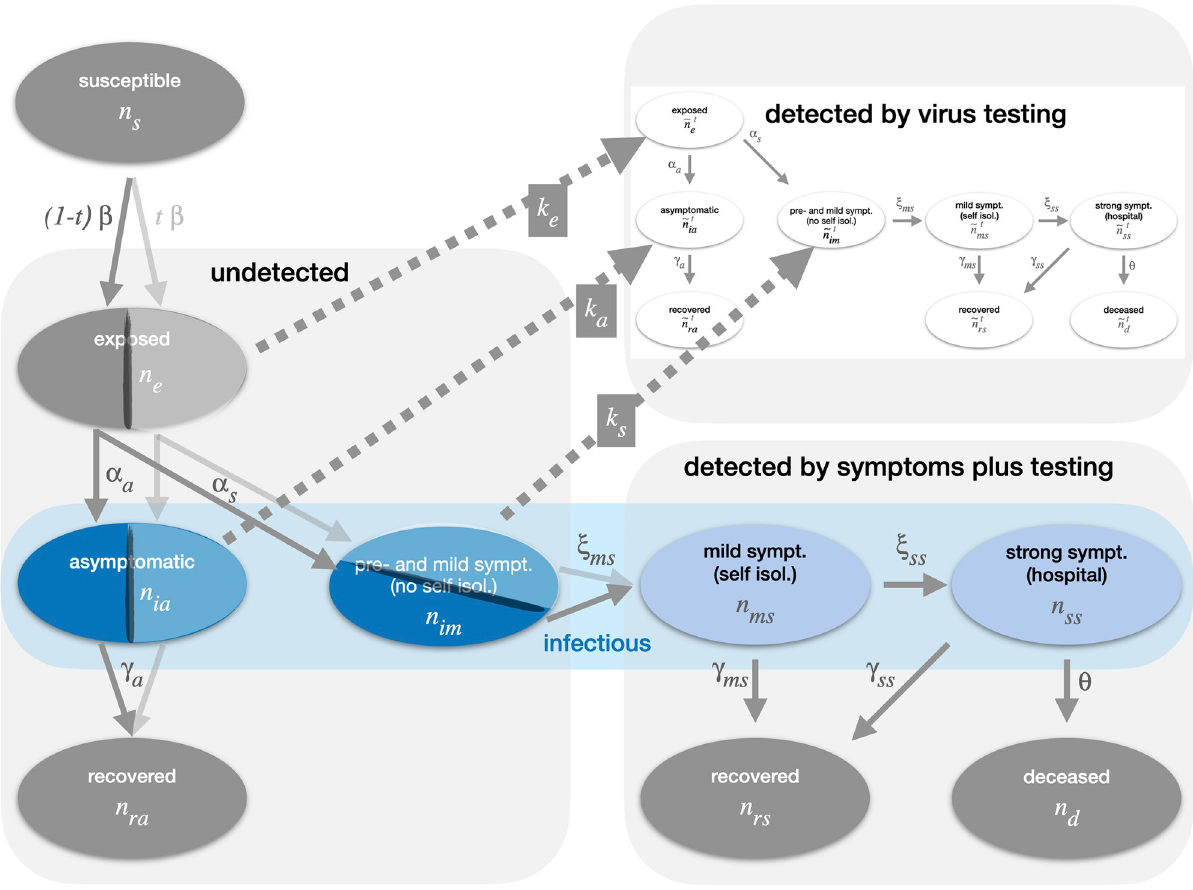
Fig 1. Graphical illustration of the modeling approach showing the dependencies within the system describing the dynamics of the susceptible, undetected and detected infected populations. It is crucial that the model distinguishes between individuals detected by symptoms (light blue), and those detected by virus testing (inserted graph). The detection rates of exposed, asymptomatic and mild symptomatic persons due to testing are proportional to k e , k a and k s , respectively. These individuals are then accounted for in the inserted graph with the white compartments, which is very similar as the main one, except that there is no node for susceptible persons (since by definition a susceptible person cannot be detected infected) and that there exist sources due to testing (dotted arrows) instead of